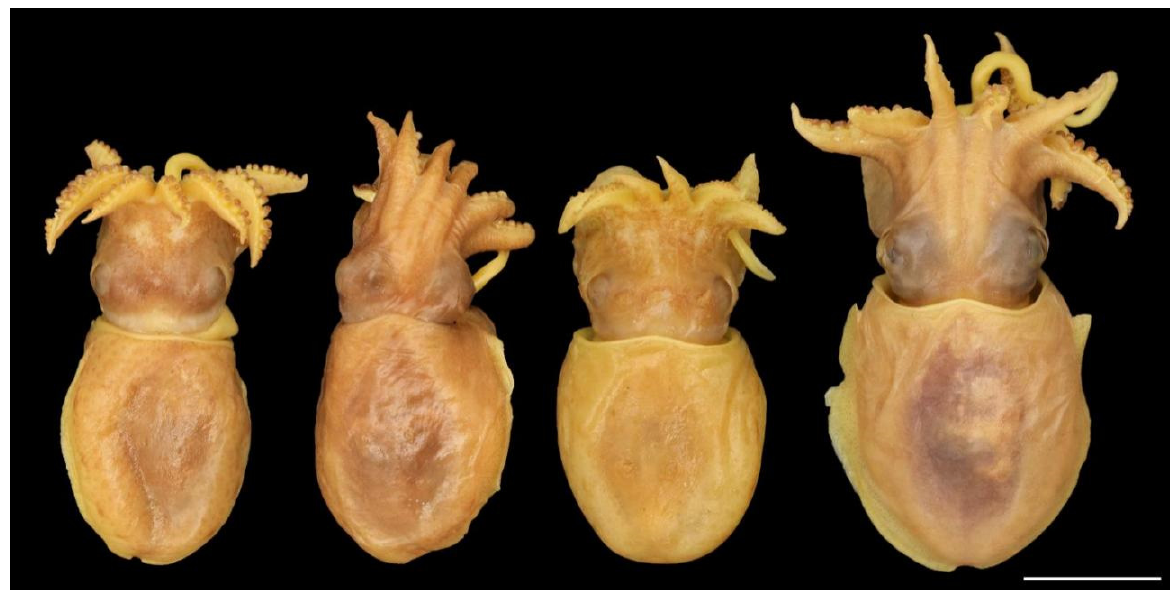
Figure 5. Variation in the shape of the dorsal mantle margin in Sepia typica : from left to right: SAIAB 211543, male ML 18 mm; SAIAB 211610, male ML 20 mm; SAIAB 211550, female ML 17 mm; SAIAB 211529, male ML 23 mm. Scale bar 10 mm.